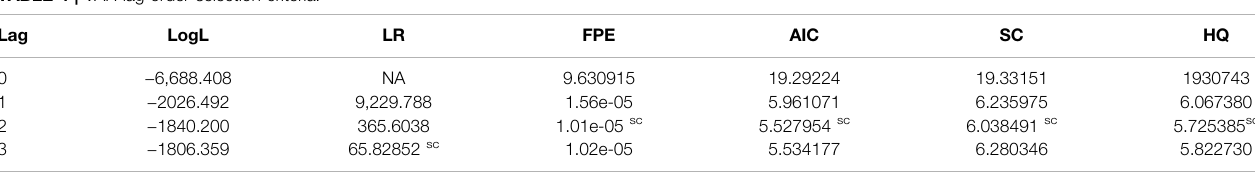
TABLE 4 | VAR lag order selection criteria.